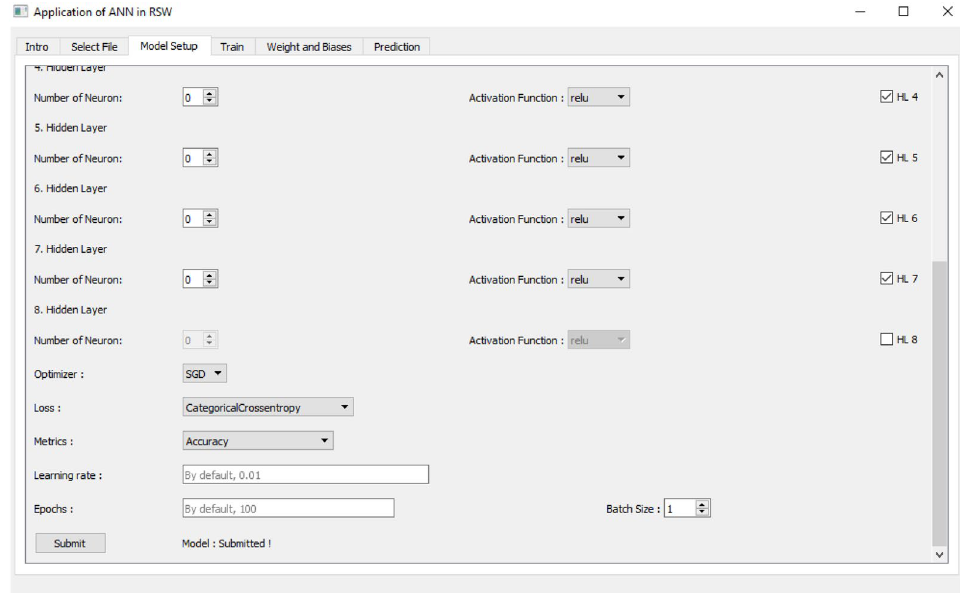
Figure 7. ANN modelling section as Tab 3.